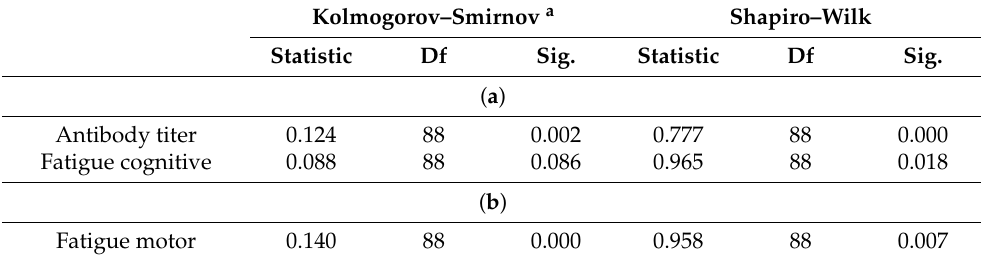
Figure 3. ( a – c ) Correlation by Spearman-Rho of circulating NfL level and fatigue severity in patients with positive anti-NR2 antibody titer (>2 ng/mL).